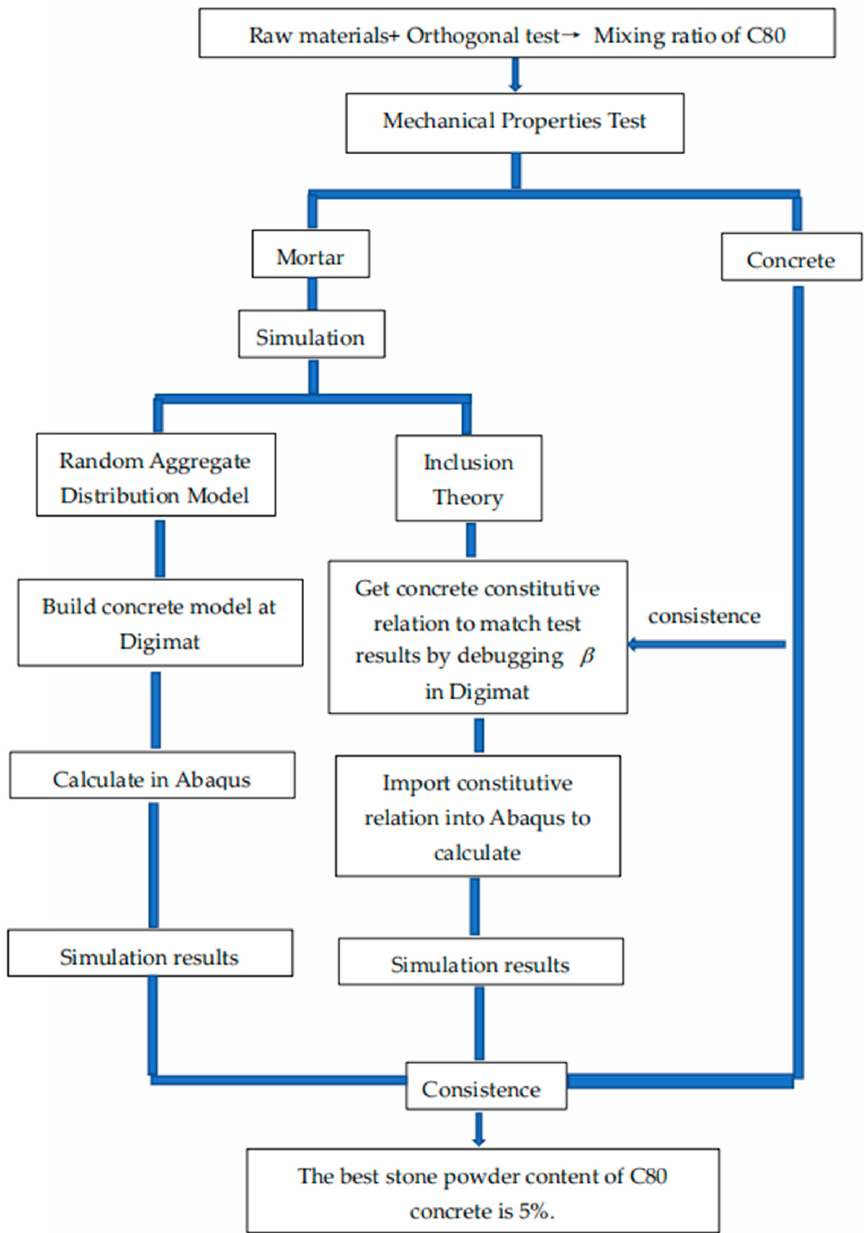
Figure 1. Flowchart representing the methodology of the work.